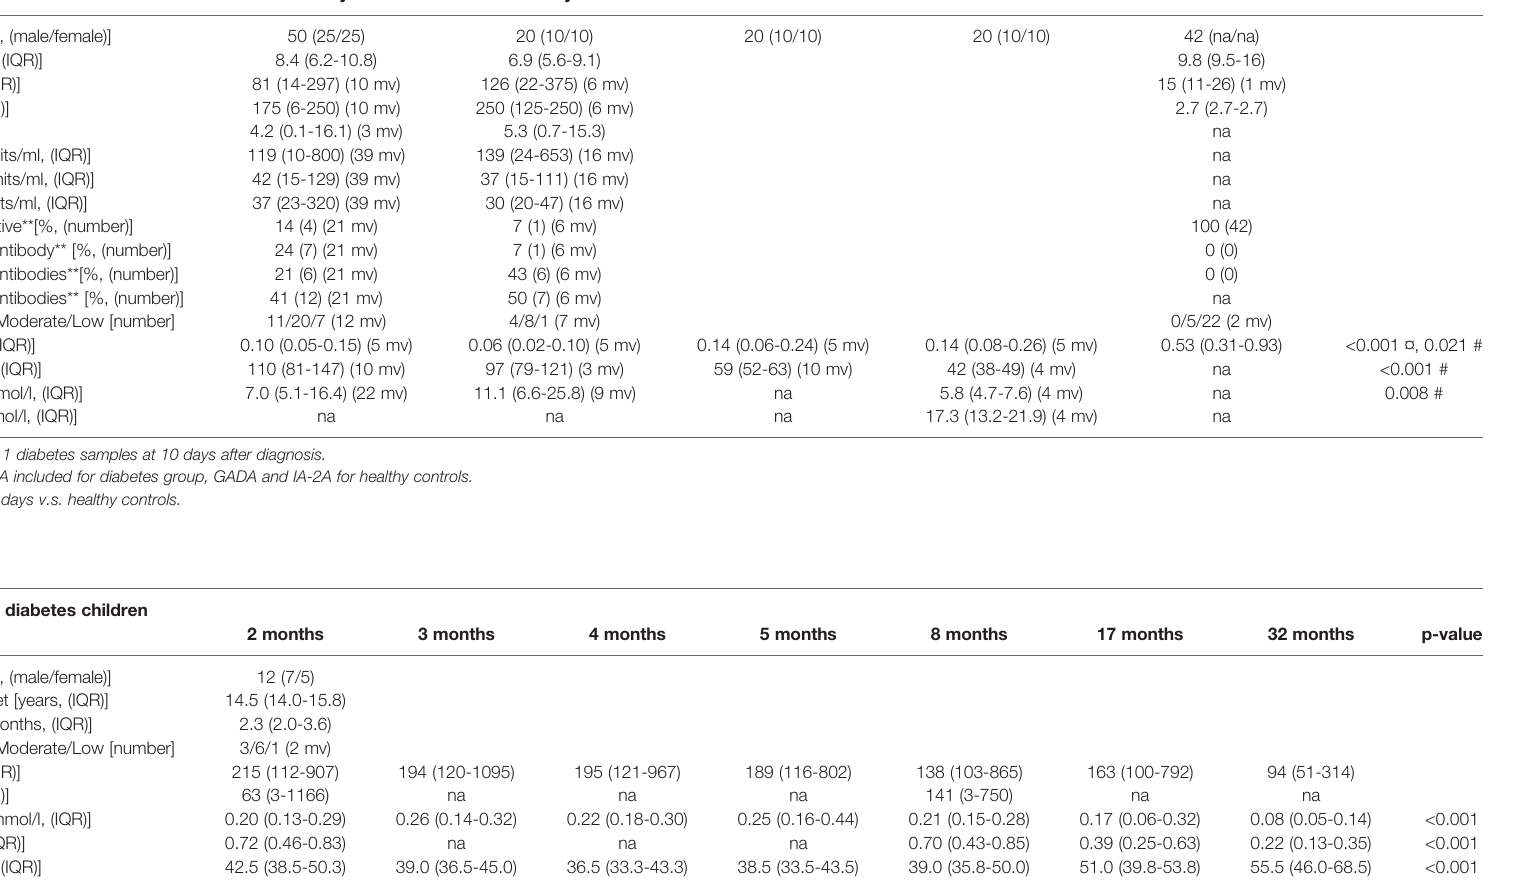
AUC, area under curve. na, not available. mv, missing